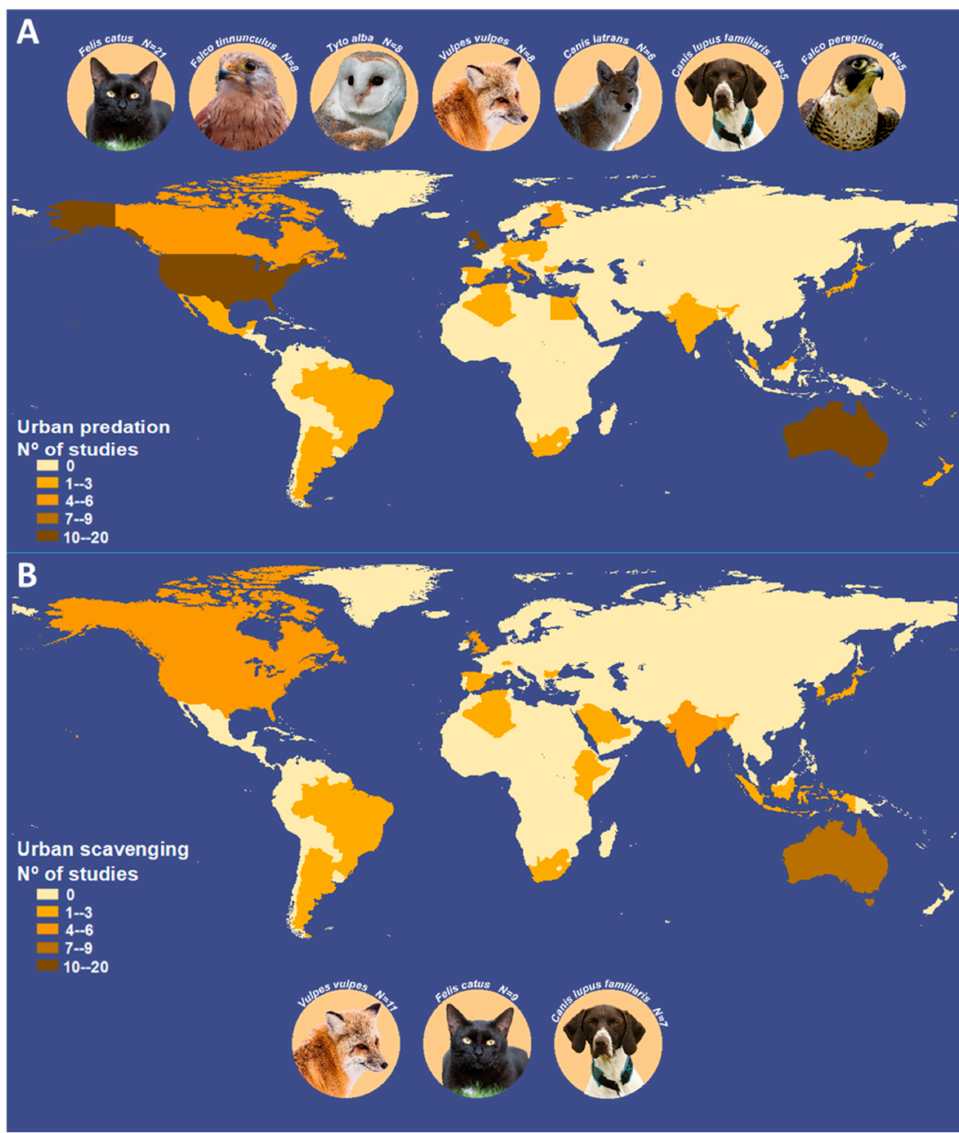
Figure 2. Number of urban predation ( A ) and scavenging ( B ) studies per country. Darker colors show high number of articles found for a given country, ranging from 0 to 20. The circles represent the species most reported in the articles (appearing on 5 or more occasions), ordered from most-reported to least-reported, from the top left corner. Pictures by: Manfredrichter, Ruthmcd, Miles, Wilda3, Skeeze and